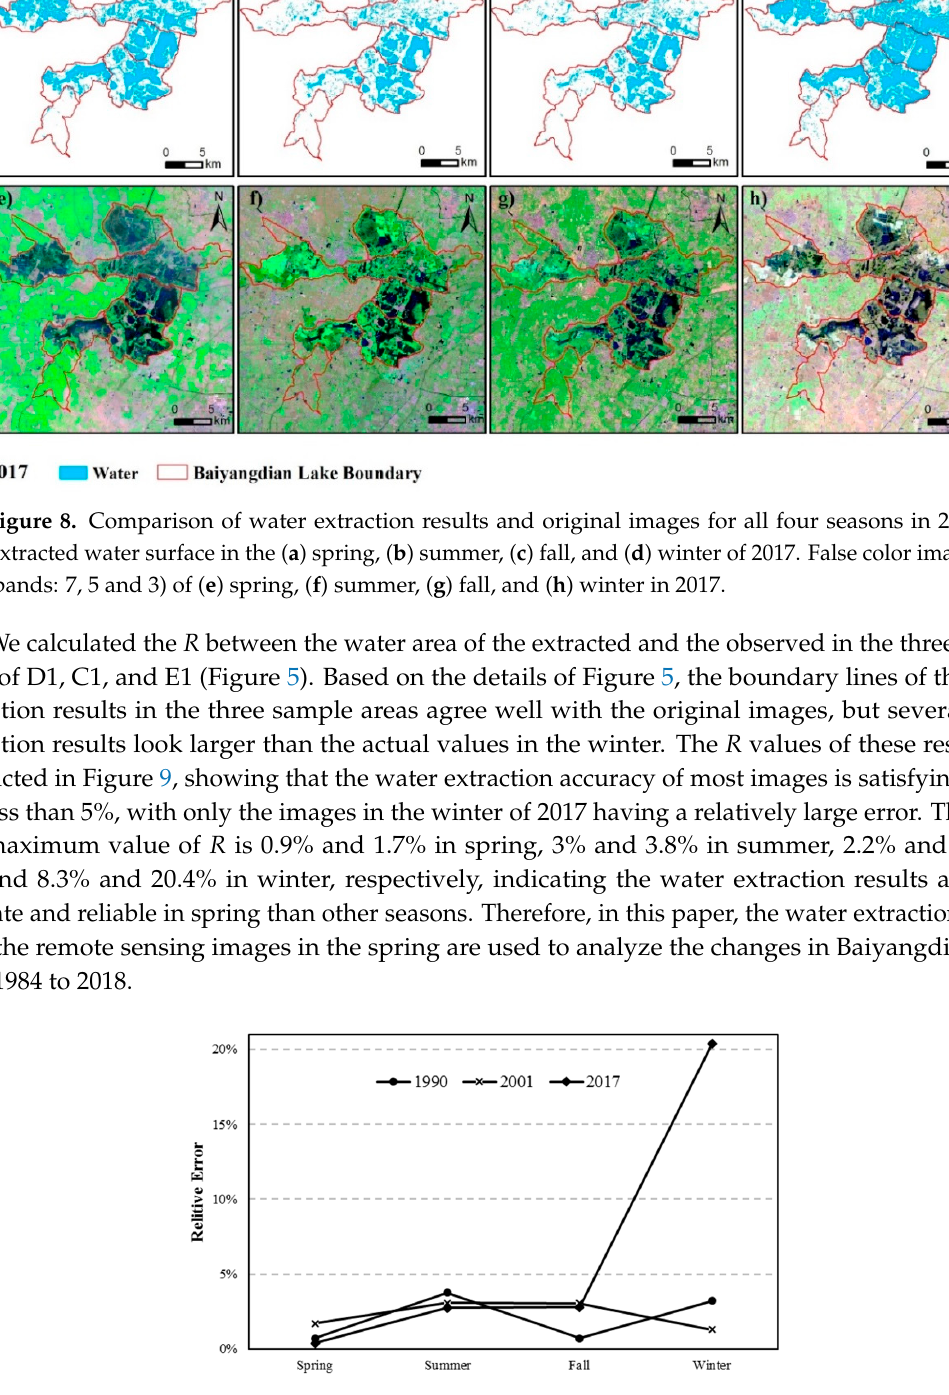
Figure 9. The relative error between the extracted water area and the actual water area.